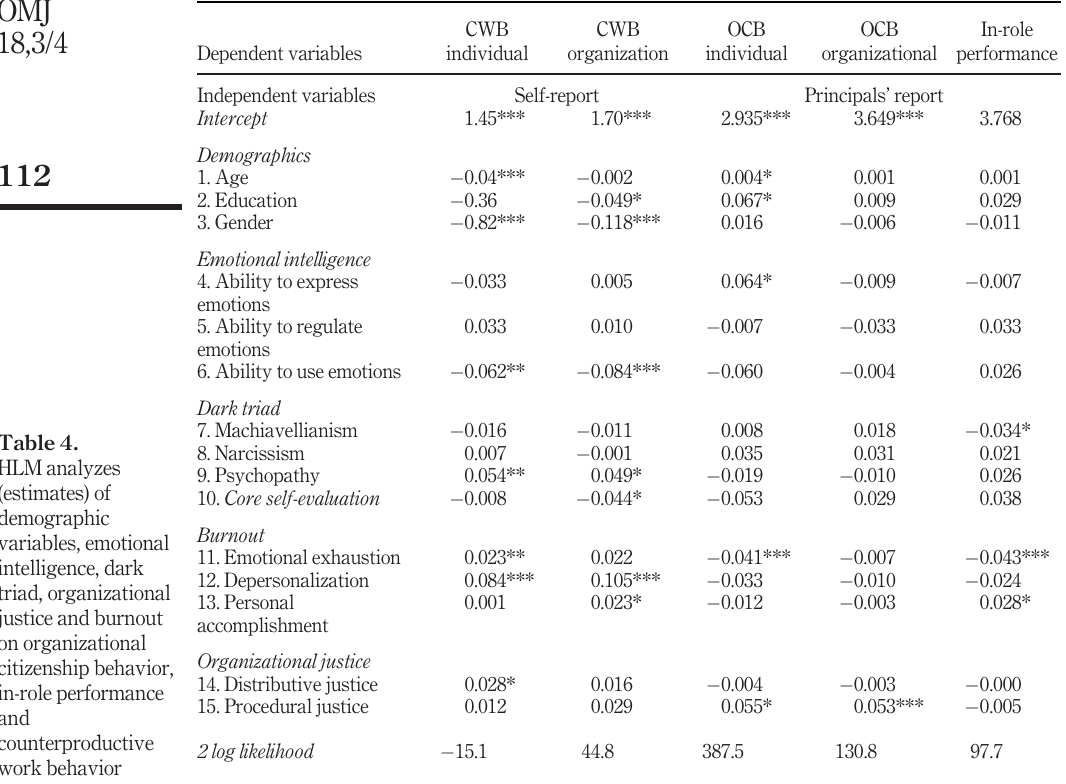
Table 4. HLM analyzes (estimates) of demographic variables, emotional intelligence, dark triad, organizational justice and burnout on